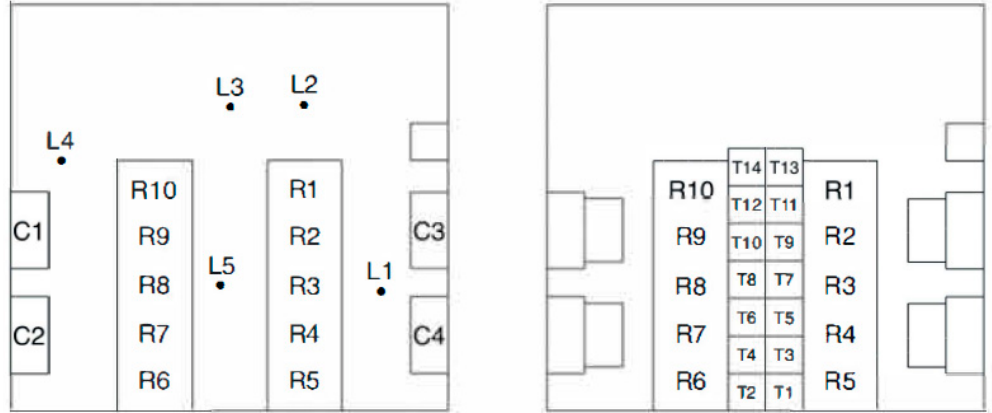
Figure 2. Labeled main components and measurement locations for (left) the hard floor configuration and (right) the raised floor configuration with open aisles.